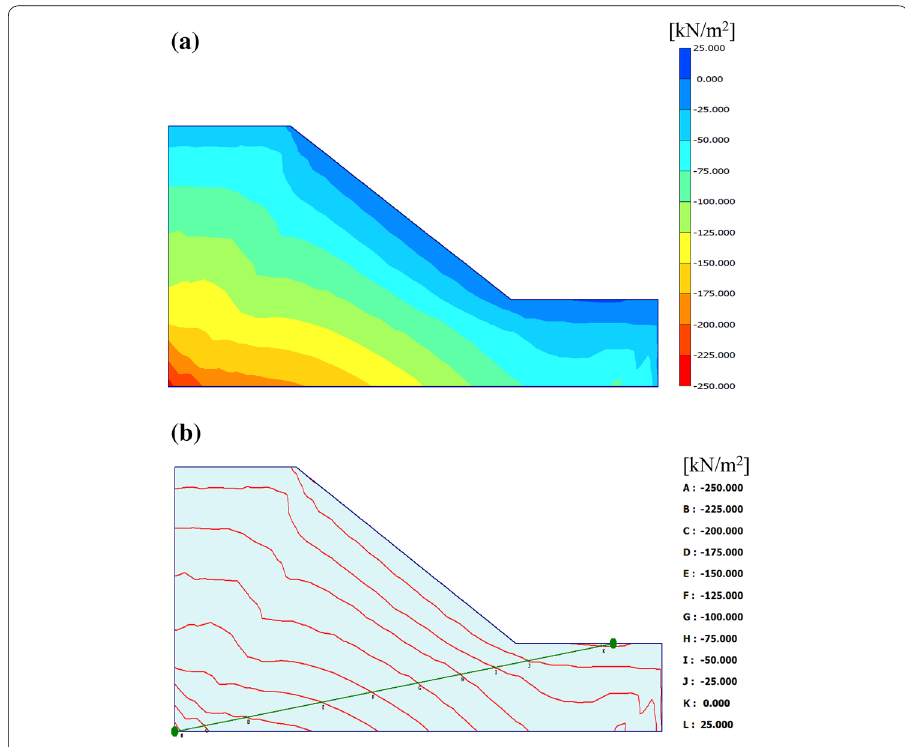
Fig. 17 The plot of total stresses β